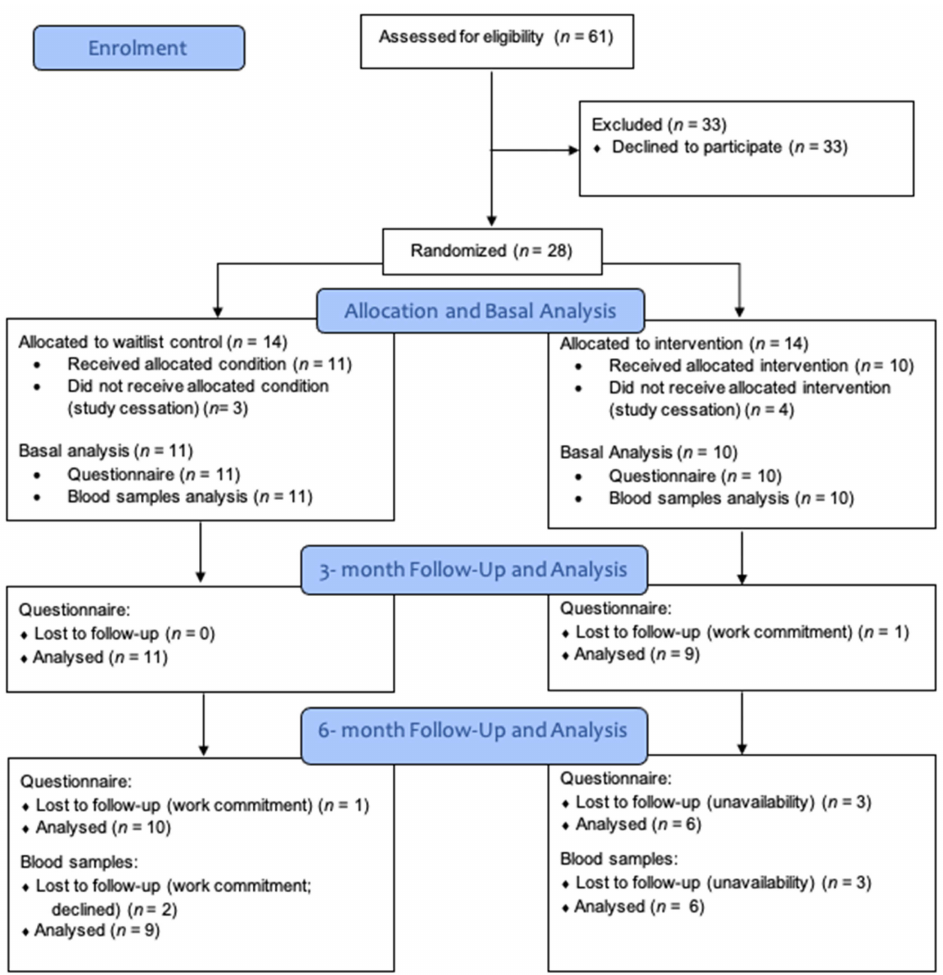
Figure 1. Participant flow